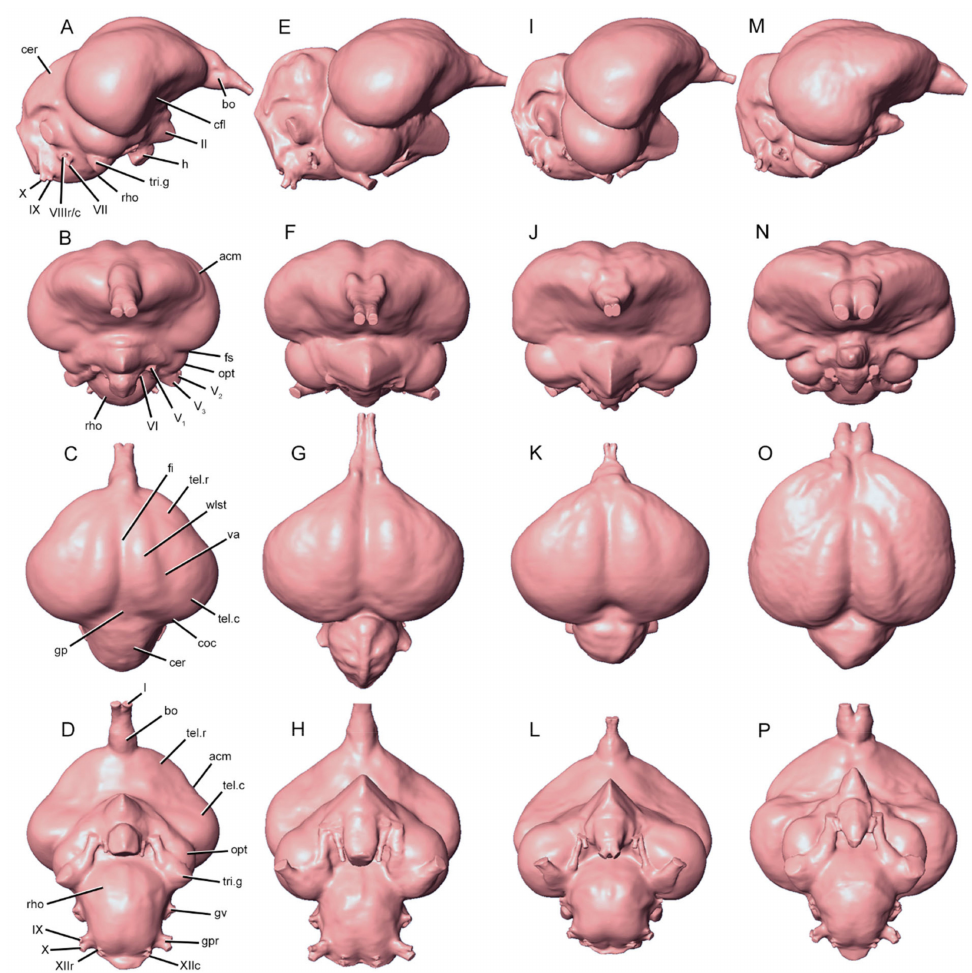
Figure 4. Galloansere endocasts. ( A – D ), Anhima cornuta (MV B12574); ( E – H ), Gallus gallus (SAM B34041); ( I – L ), Leipoa ocellata (SAM B11482); and ( M – P ), Anseranas semipalmata (SAM B48035). Views: Right lateral ( A , E , I , M ); Rostral ( B , F , J , N ); Dorsal ( C , G , K , O ); Ventral ( D , H , L , P ). The full extension of the olfactory ( I ) nerves in G. gallus are shown in dorsal ( G ) view, but were cropped in lateral ( E ) and ventral ( H ) views to fit the plate. Abbreviations: acm, arteria cerebralis medialis; bo, olfactory bulb; cer, cerebellum; cfl, cerebrum fovea limbica; coc, cerebrum pars occipitalis; fi, fissura interhemispherica; fs, fissura subhemispherica; gp, glandula pinealis; gpr, proximal ganglion; gv vestibular ganglion; h, hypophysis (note the caudoventral hypophysis has been trimmed to facilitate access to rostroventral rhombencephalon surfaces); opt, optic lobe; rho, rhombencephalon; tel.c, caudal telencephalon; tel.r, rostral telencephalon; tri.g, trigeminal ganglion; va, vallecula telencephali; wlst, wulst; I, olfactory nerve; II, optic nerve; V 1 , ophthalmic nerve; V 2 , maxillary nerve; V 3 , mandibular nerve; VI, abducent nerve; VII, facial nerve; VIIIr/c, rostral and caudal rami of the vestibulocochlear nerve; XIIr, rostral and; XIIc, caudal rami of the hypoglossal nerve. Endocasts are not to